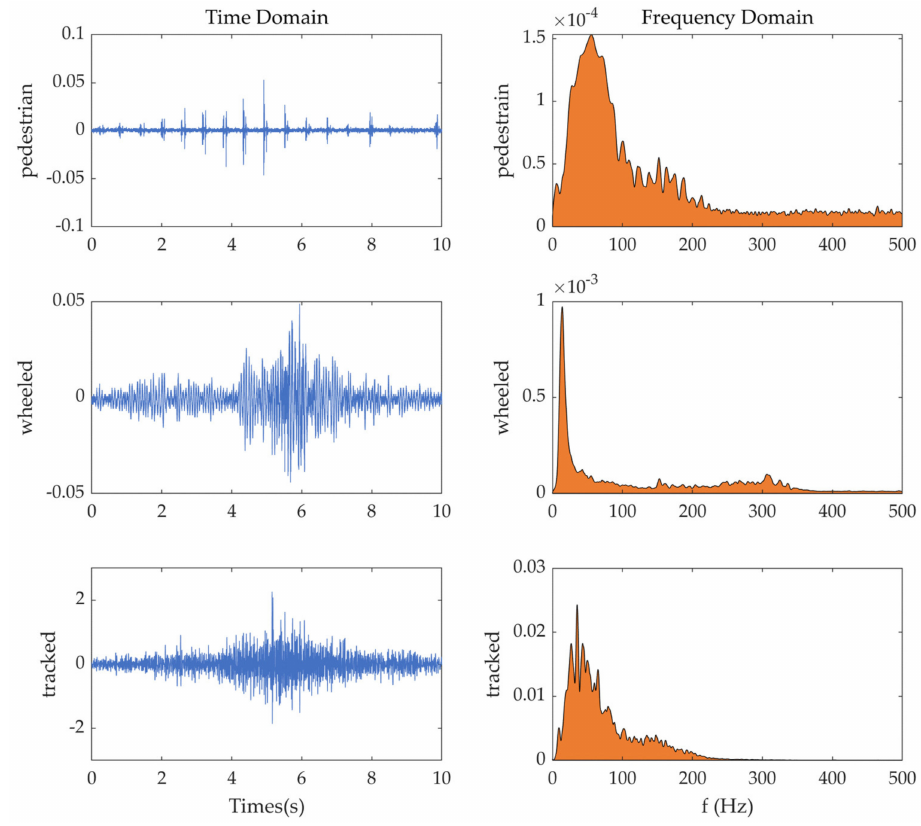
Figure 9. Targets’ Vibration Signal Distribution in time domain and frequency